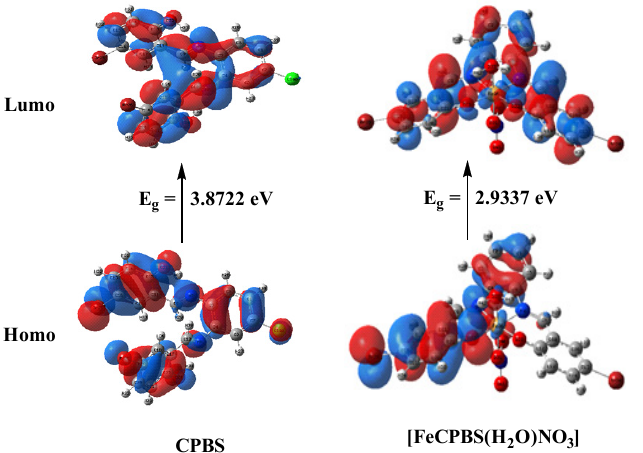
Figure 6. HOMO and LUMO charge density maps of PDBS, CPBS, and their Fe (III) ([FePDBS(H 2 O) NO 3 ] and [FeCPBS(H 2 O)NO 3 ]).